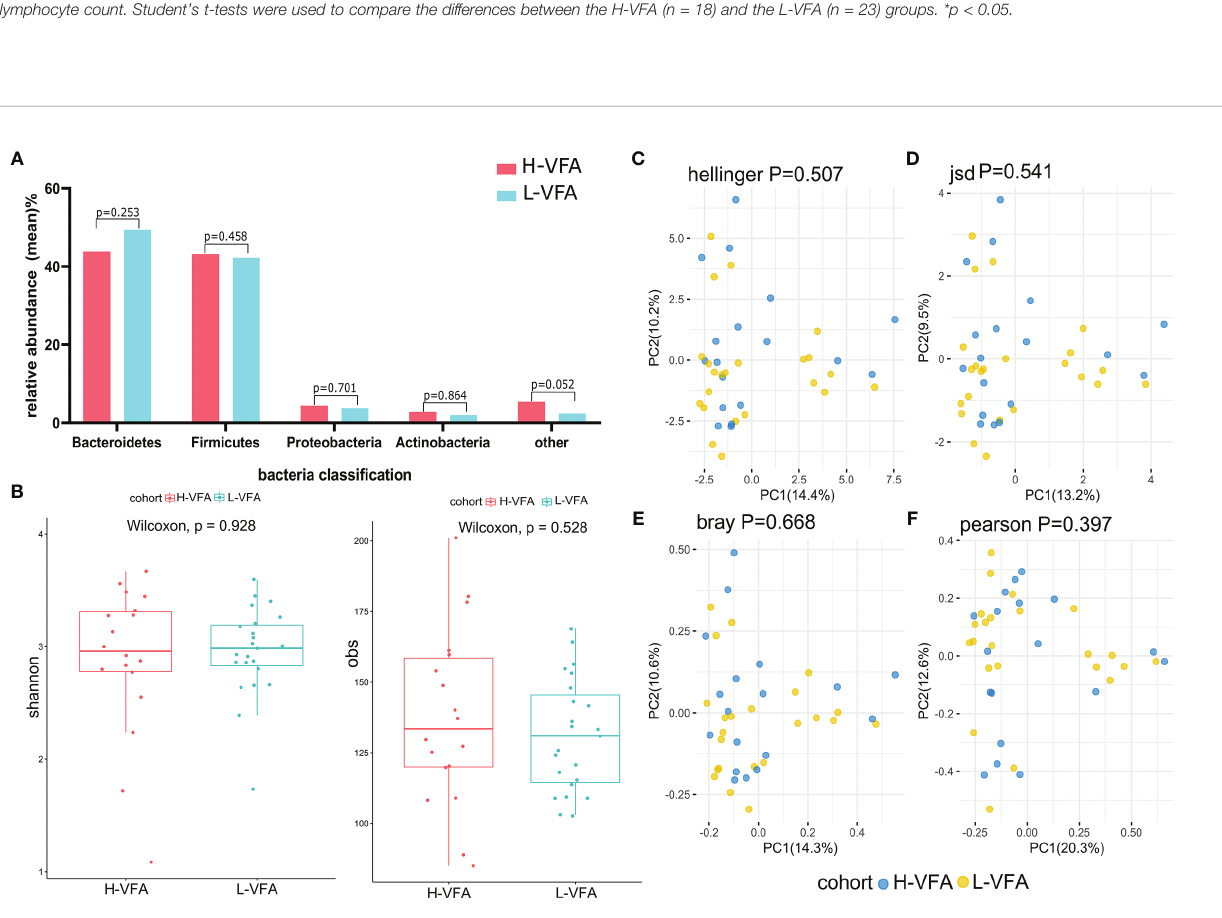
FIGURE 1 | Microbiome composition and diversity. (A) No signi fi cant differences were found in the phyla of the H-VFA group and L-VFA group ( p > 0.05). (B) Both Shannon index and obs index measured alpha diversity in comparisons between the H-VFA group and L-VFA group. There was no signi fi cant difference in the level of microbial species between the two groups (p = 0.928 and p = 0.528). (C – F) Beta diversity between the H-VFA group and L-VFA group. Beta diversity was calculated based on the Hellinger distance, JSD distance, Bray distance, or Pearson distance. There were no signi fi cant differences between the H-VFA group and the L-VFA group.